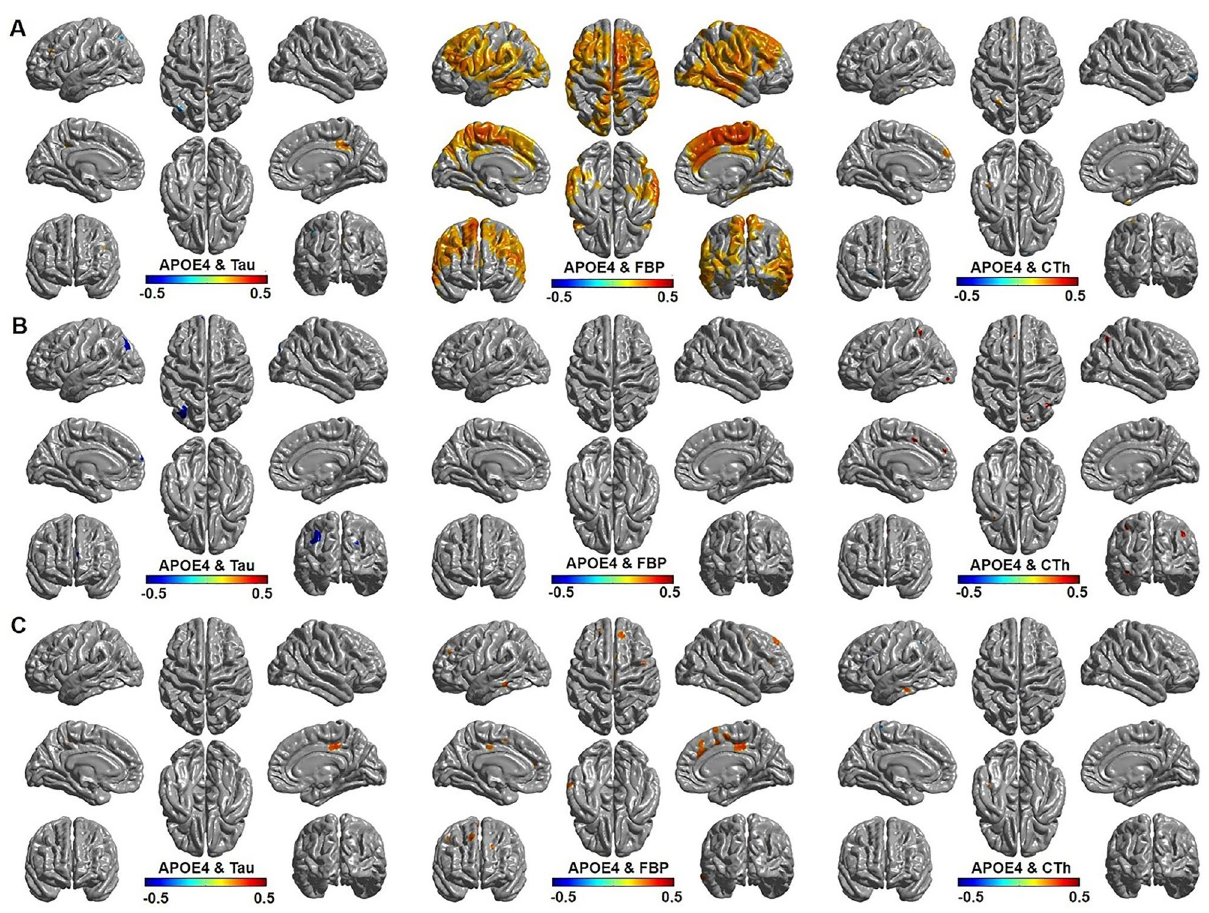
Figure 2. Vertex-wise point biserial correlation analysis between APOE4 status (APOE4 carrier = 1, non- carrier = 0) and the variables (tau, amyloid, and cortical thickness controlling for age and sex by FDR corrected p < 0.05). ( A ) Correlation between APOE4 and biomarkers in all cognitive normal participants; ( B ) Correlation between APOE4 and biomarkers in cognitive normal Aβ+ participants; ( C ) Correlation between APOE4 and biomarkers in cognitive normal Aβ− participants. Tau burden (left), amyloid burden (mid), and cortical thickness